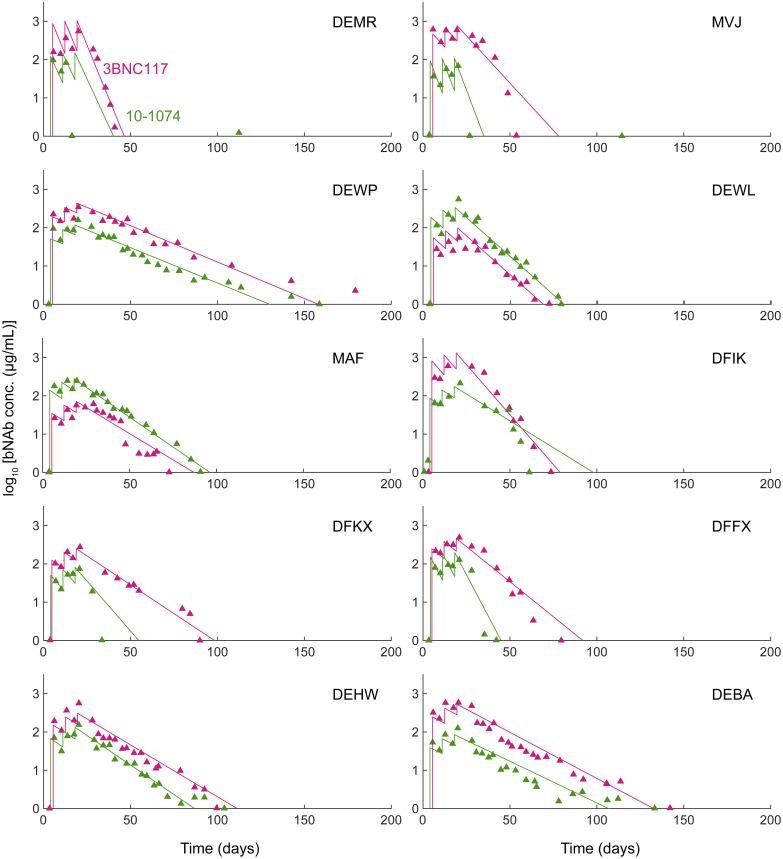
bNAb pharmacokinetics in responders.Fits of model predictions (lines) to data from individual macaques (symbols) of bNAb plasma concentrations for the ten responders in Nishimura et al. [10] obtained by simultaneously fitting our model (Eqs 13–20) to V, A1 and A2 across all macaques. Methods for the fitting procedure. The resulting parameter estimates are in S1 Table. The bNAb serum half-lives averaged across all macaques are 9.0 days (range 2.7–15.8 days) for 3BNC117, and 8.2 days (range 2.5–16.3 days) for 10-1074.